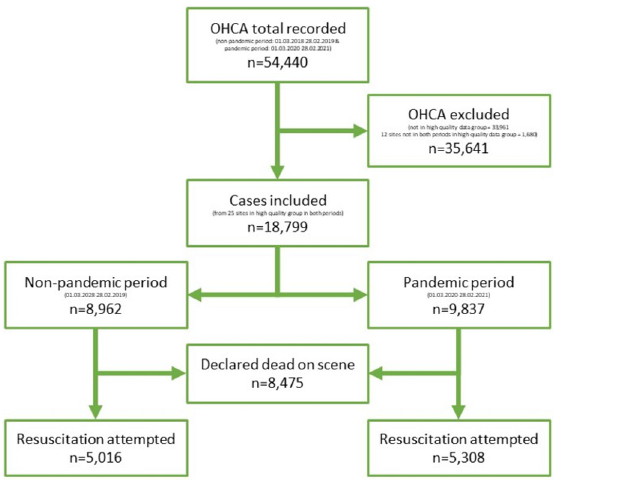
Fig 1. Flowchart of in- and